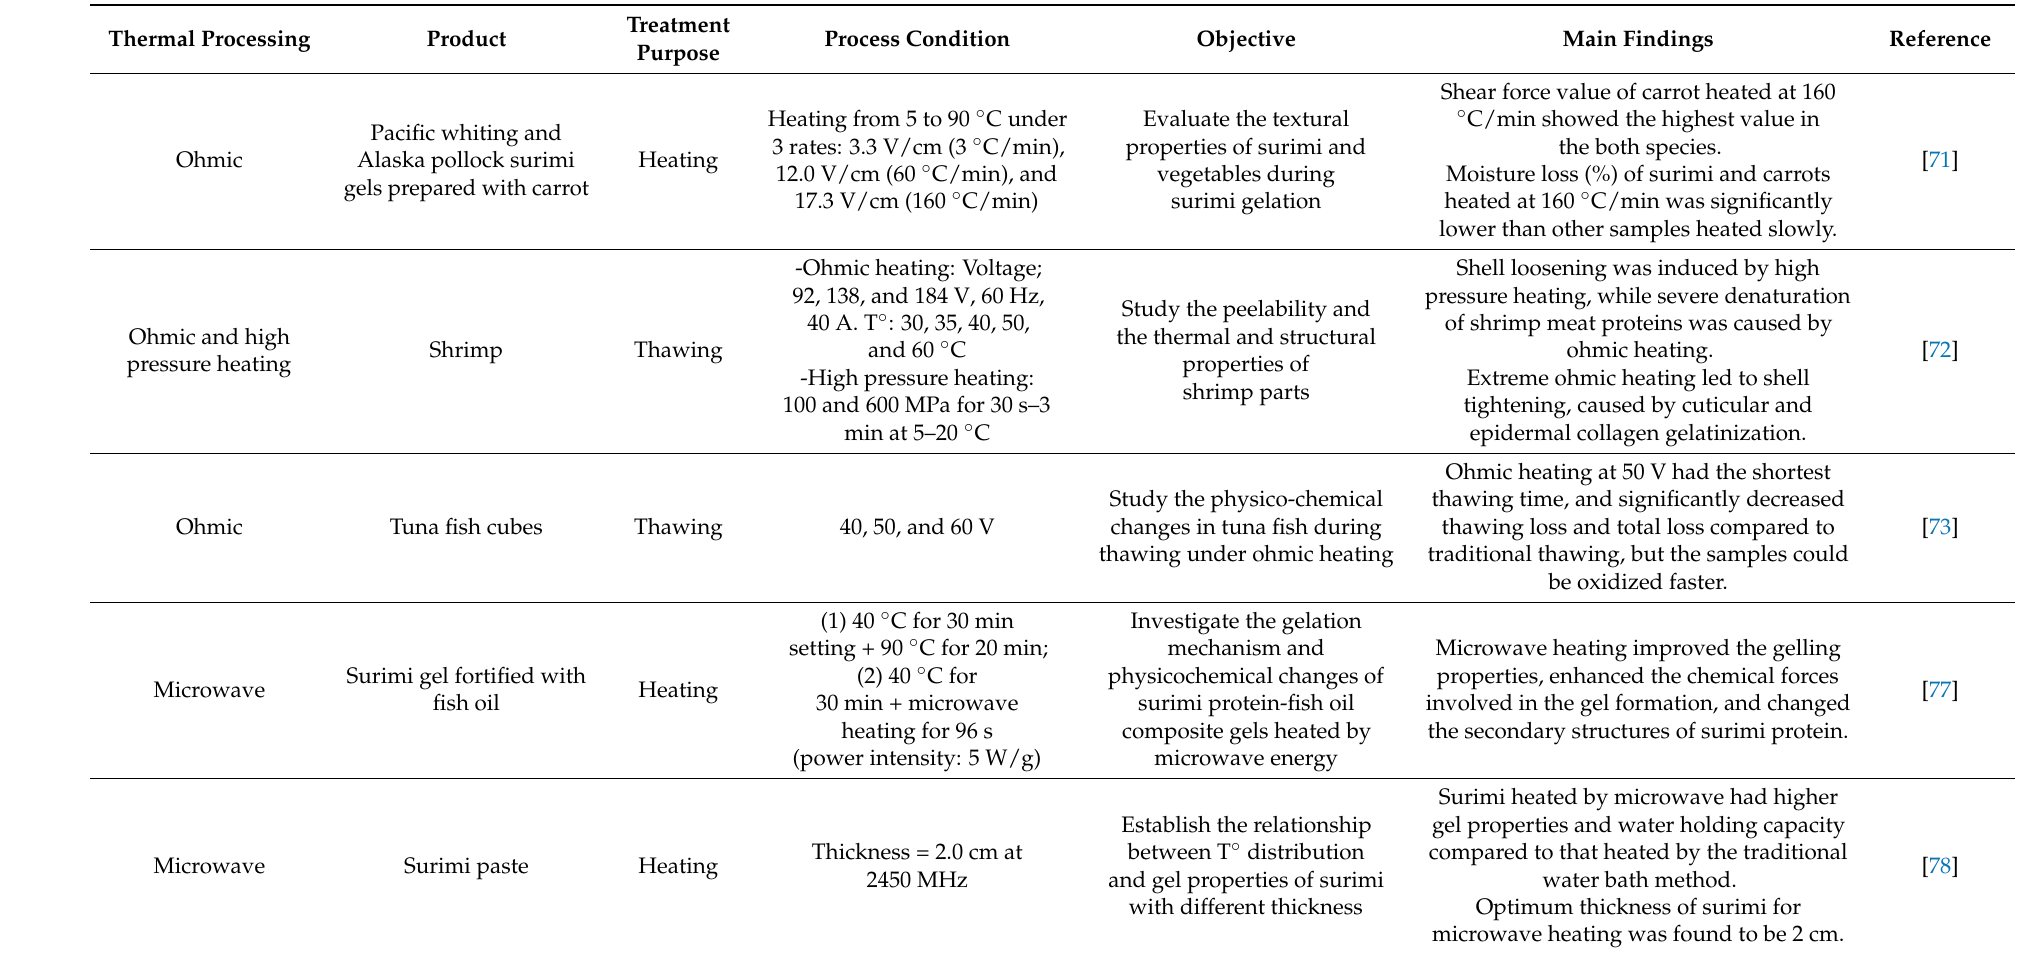
Table A1. Use of thermal processing methods in seafood